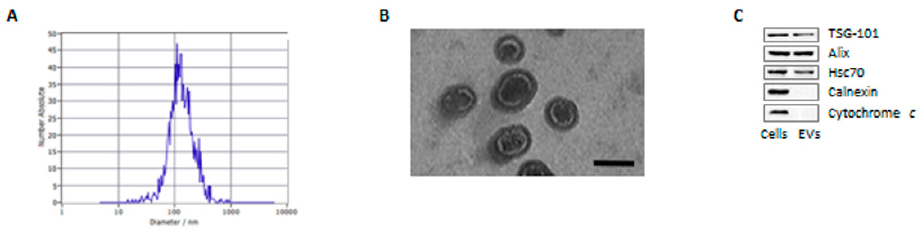
Figure 1. Characterization of adipocyte-derived extracellular vesicles. ( A ) EV size measured by nanoparticle tracking analysis. ( B ) EV morphology visualized by transmission electron microscopy. Scale bar is 100 nm. ( C ) Western blot analysis was performed to investigate the expression levels of TSG101, Alix, Hsc70, calnexin and cytochrome c in 3T3-L1 adipocytes and in their EVs. One representative of three experiments performed is shown.